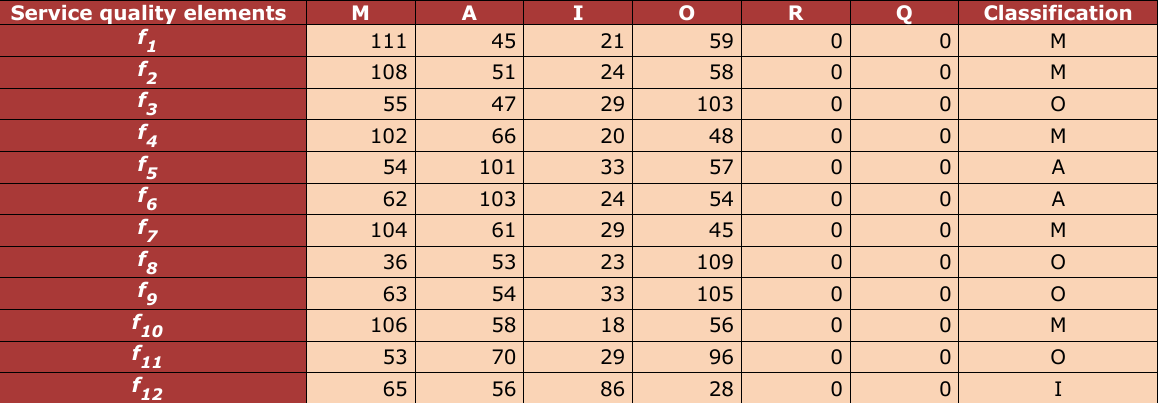
Table 6. Classification of service quality elements when α=0.1